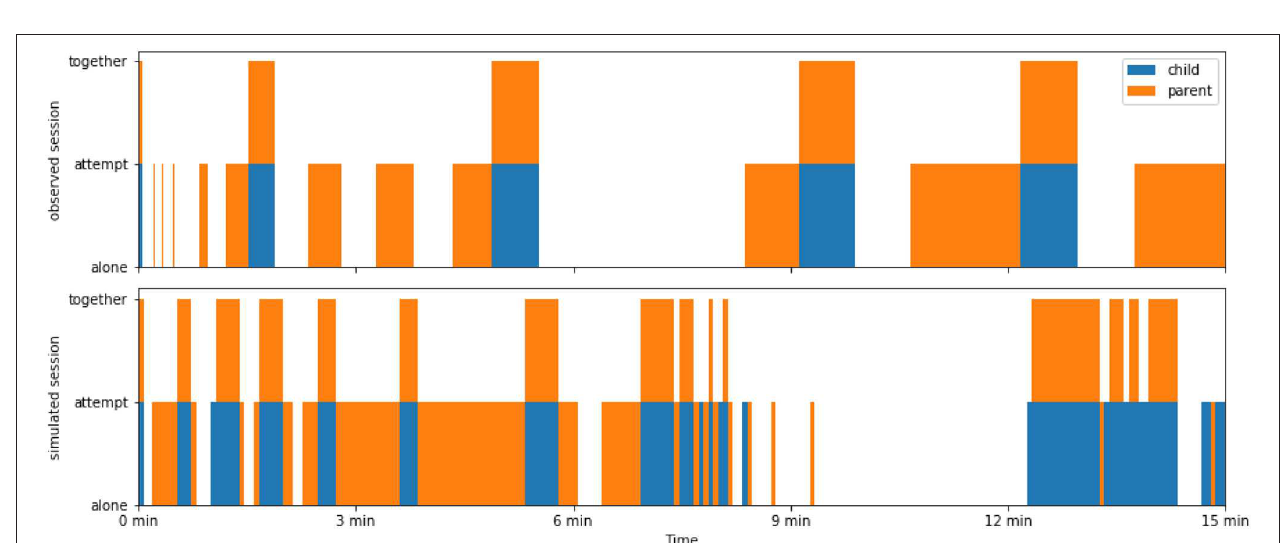
FIGURE 3 | An illustrative comparison of the play dynamics of parent and child as they unfold over the course of 15 min in one example of an observed session (upper panel) and one of a session simulated with SECONDS (lower panel; involving the initiative-centered parent). These stacking plots indicate with colored areas when the parent (orange) and child (blue) are engaging in other-directed play behavior. The absence of blocks indicates they are both playing alone , single blocks (either orange or blue) indicate one of them is attempting to initiate play ( attempt child or attempt parent ), and two stacked blocks (orange and blue) indicate they are playing together . The qualitative similarities between these panels are striking. However, both the observed dyad and the simulated dyads exhibit large variability across sessions, so a comparison across sessions as shown in Figure 4 is